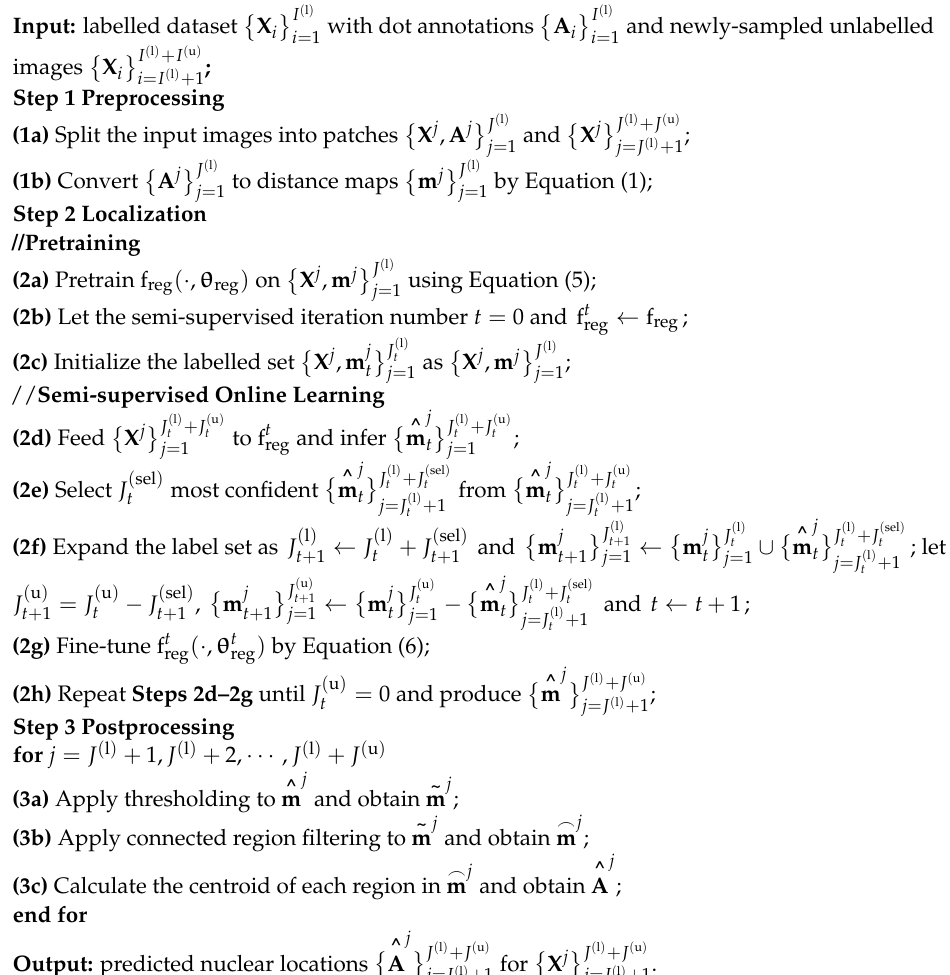
Algorithm 1 Implementation details of the nuclear